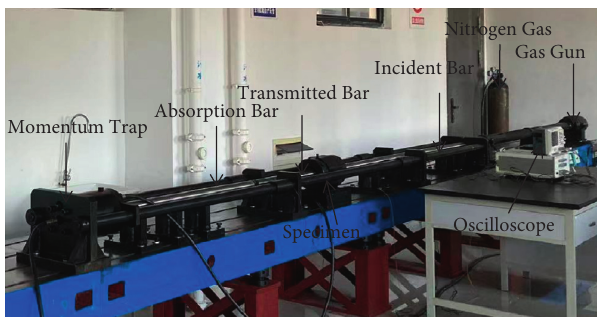
Figure 1: SPHB experimental device.